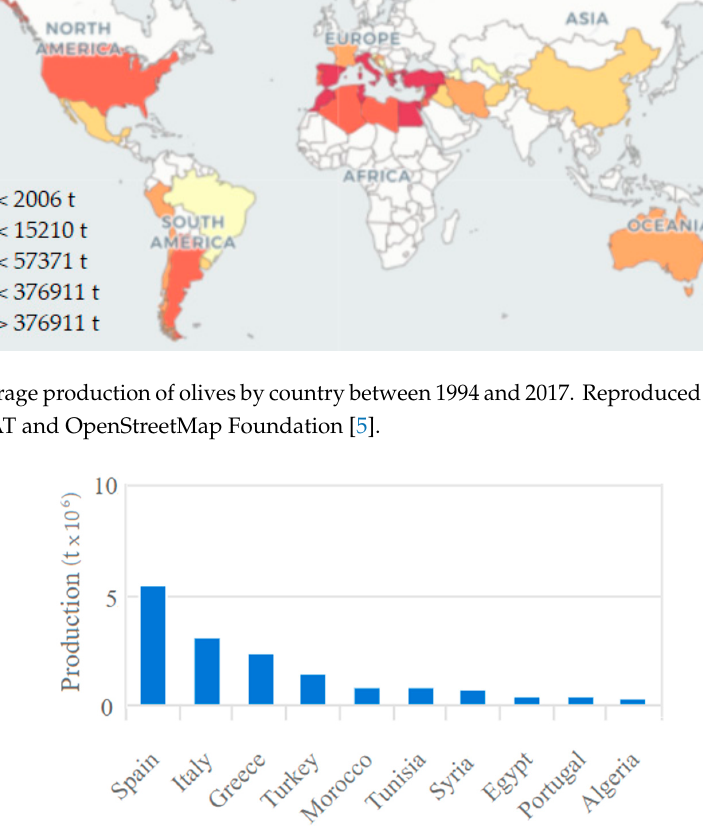
Figure 3. Average olive production (1994–2017) of the top 10 olive producers. Reproduced with permission from FAOSTAT [5].